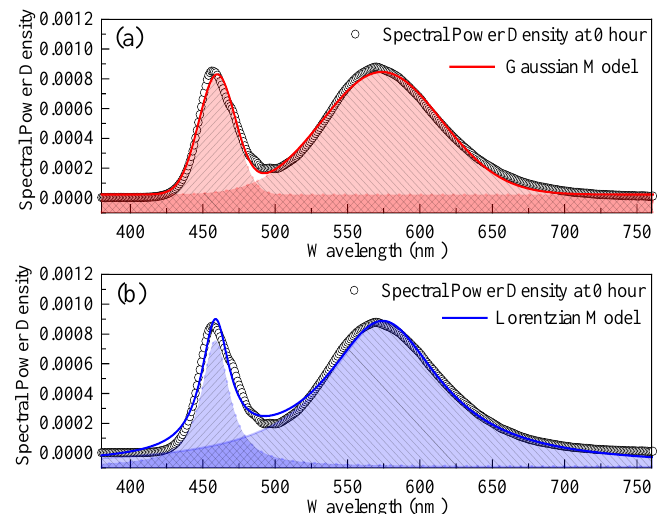
Figure 4. Feature extraction from the initial SPD of pc-WLED package with both Gaussian and Lorentzian models (the red ( a ) and blue ( b ) dash lines with shadow areas represent the Gaussian and Lorentzian models respectively).